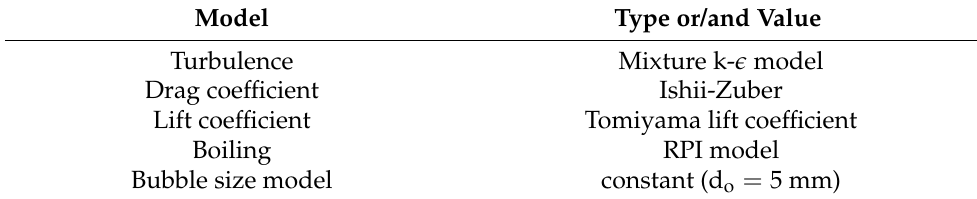
Table 8. Basic setup of CFD Model in ANSYS CFX